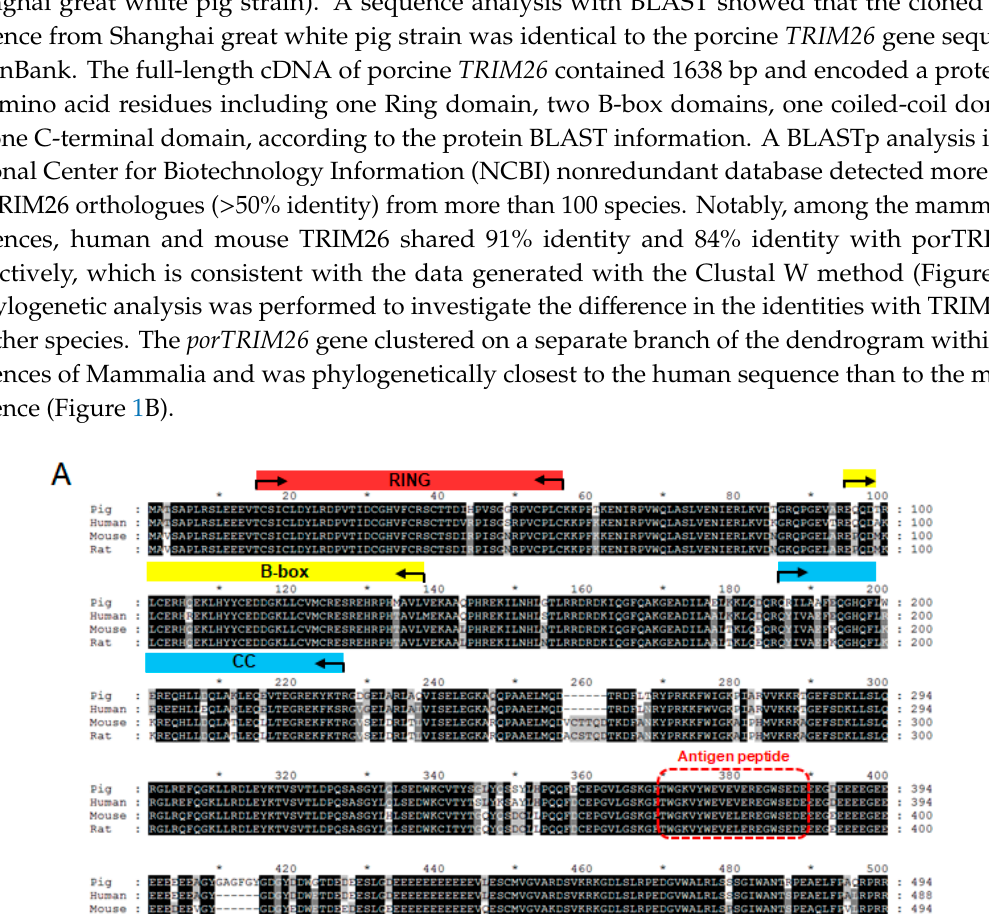
Figure 1. Multiple alignment and phylogenetic analysis of TRIM26. ( A ) Polypeptide of porcine TRIM26 was aligned with that of human, mouse, and rat. The RING finger domain (RING), the B-box domains (B-box), and the coiled-coil region (CC) are labeled in reference to the human TRIM26. The antigenic peptide is shown in the red box. ( B ) The phylogenetic tree of TRIM26, constructed by neighbor-joining method using MEGA 6.06.